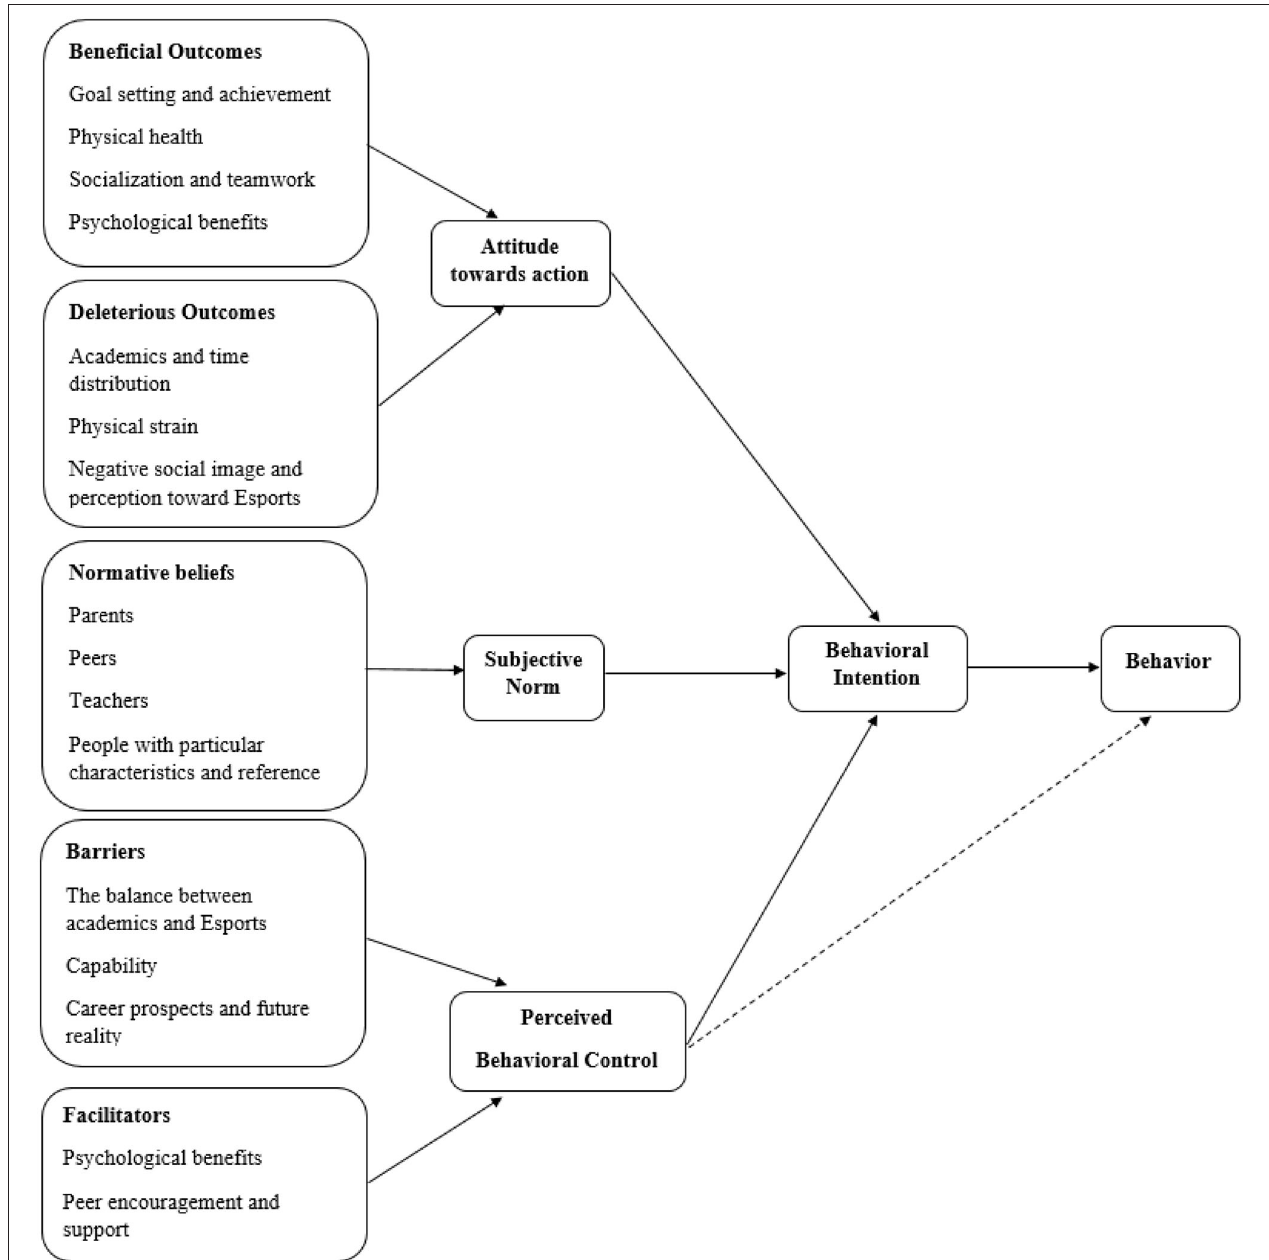
FIGURE 1 | Theory of planned behaviors of Esports participation (Ajzen, 1991).